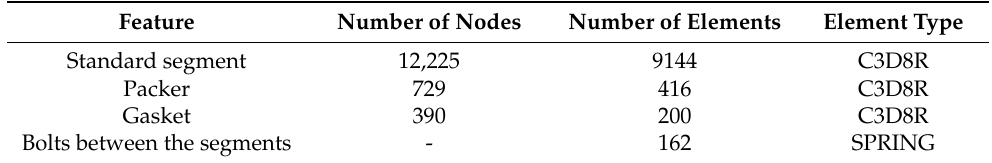
Table 2. Mesh properties for the FE modelling.